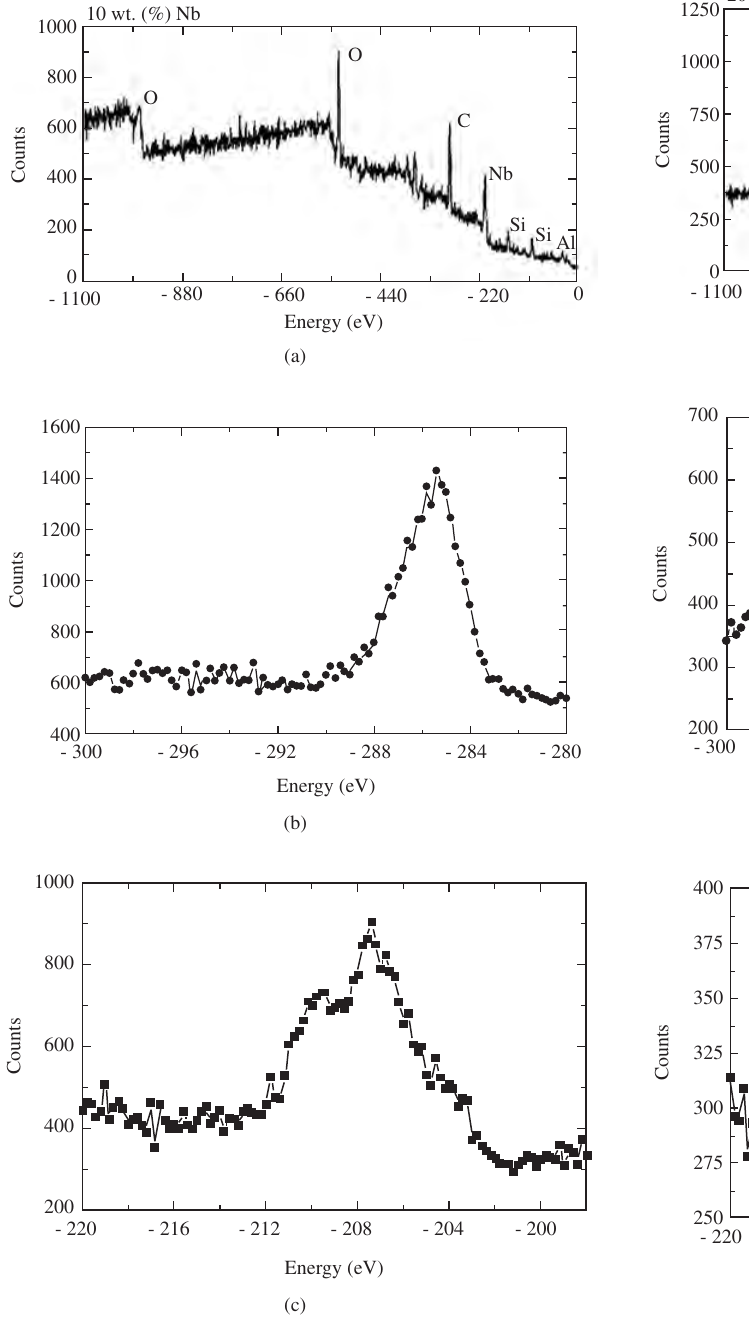
Figure 2. XPS analysis of the sample with 20 wt. (%) Nb, showing the spec- trum of: a) general chemical specimens; b) carbon; and c) niobium.